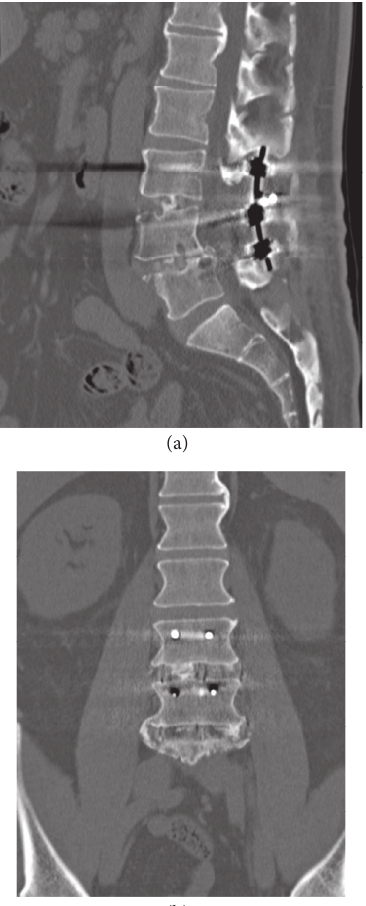
(b) Figure5:CT12monthsaftersurgery.Sagittalimageatthemidspinal canal (a); coronal image at the midvertebral body (b). Bridging bone formation is present at the edge of the cage inserted at the L3/4 and L4/5 intervertebral